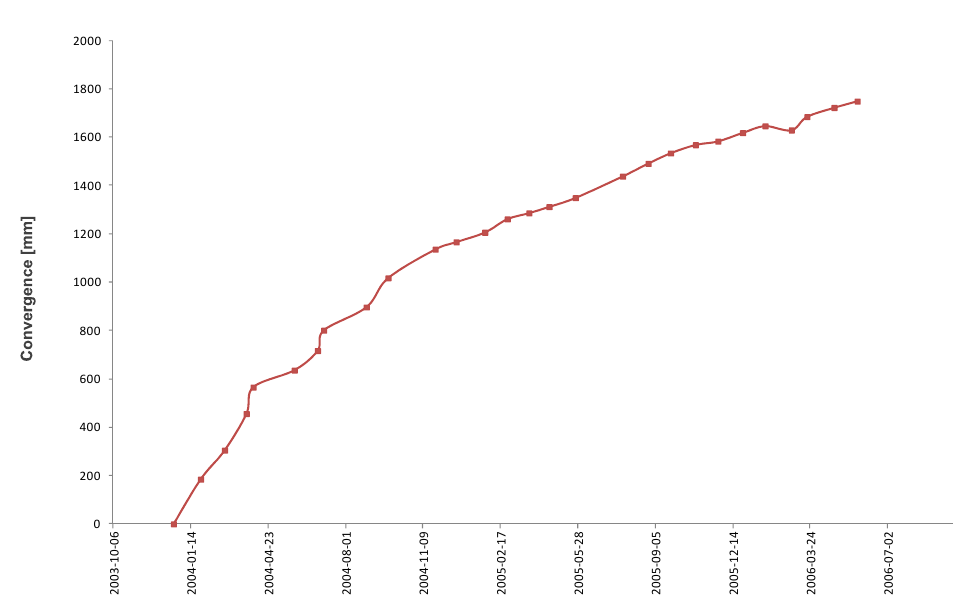
Figure 7. The results of excavation convergence measurements for J-UGR-PS mining system in Polkowice-Sieroszowice mine.